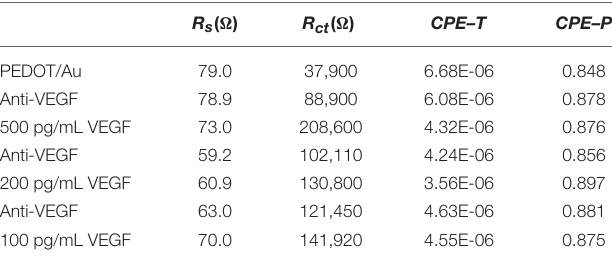
TABLE 1 | The fitted result of the impedance spectra in Figure 3 obtained from ZView software.